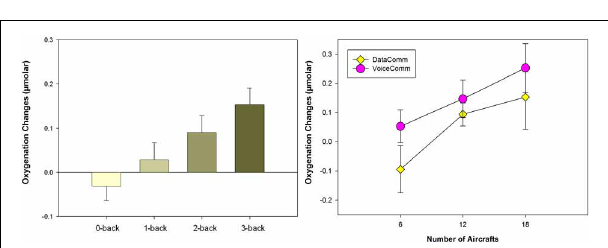
FIGURE 2 | (Left) Average oxygenation changes of all subjects (24 participants, and 28 trials for each participant) with increasing task difficulty. ( Right ) Average oxygenation changes for two different interfaces (data- and voice-based) and for 6, 12, and 18 aircraft conditions each. Error bars are standard error of the mean